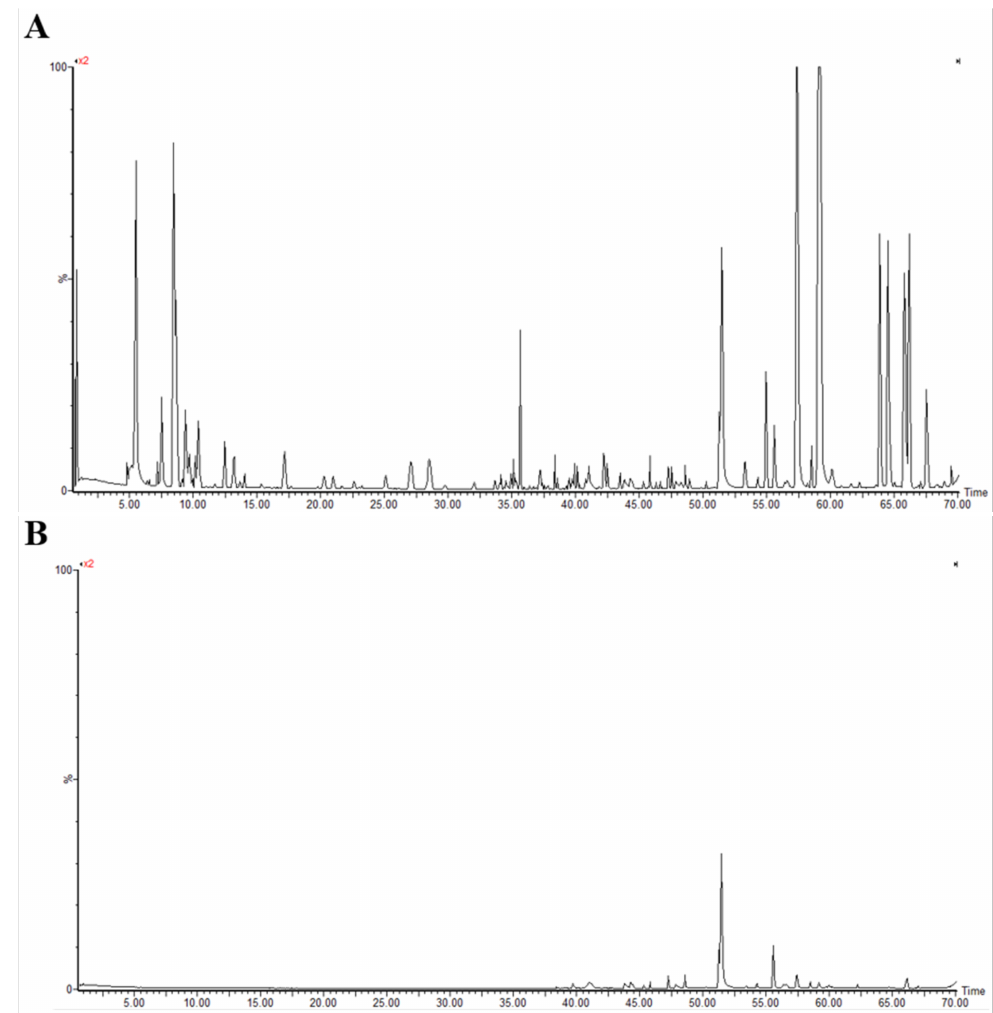
Figure 2. The base peak chromatograms of purified polyphenols from Mallotus oblongifolius ( A ) and the control of acetonitrile ( B ) by UPLC-Q-TOF/MS analysis under positive ion mode.